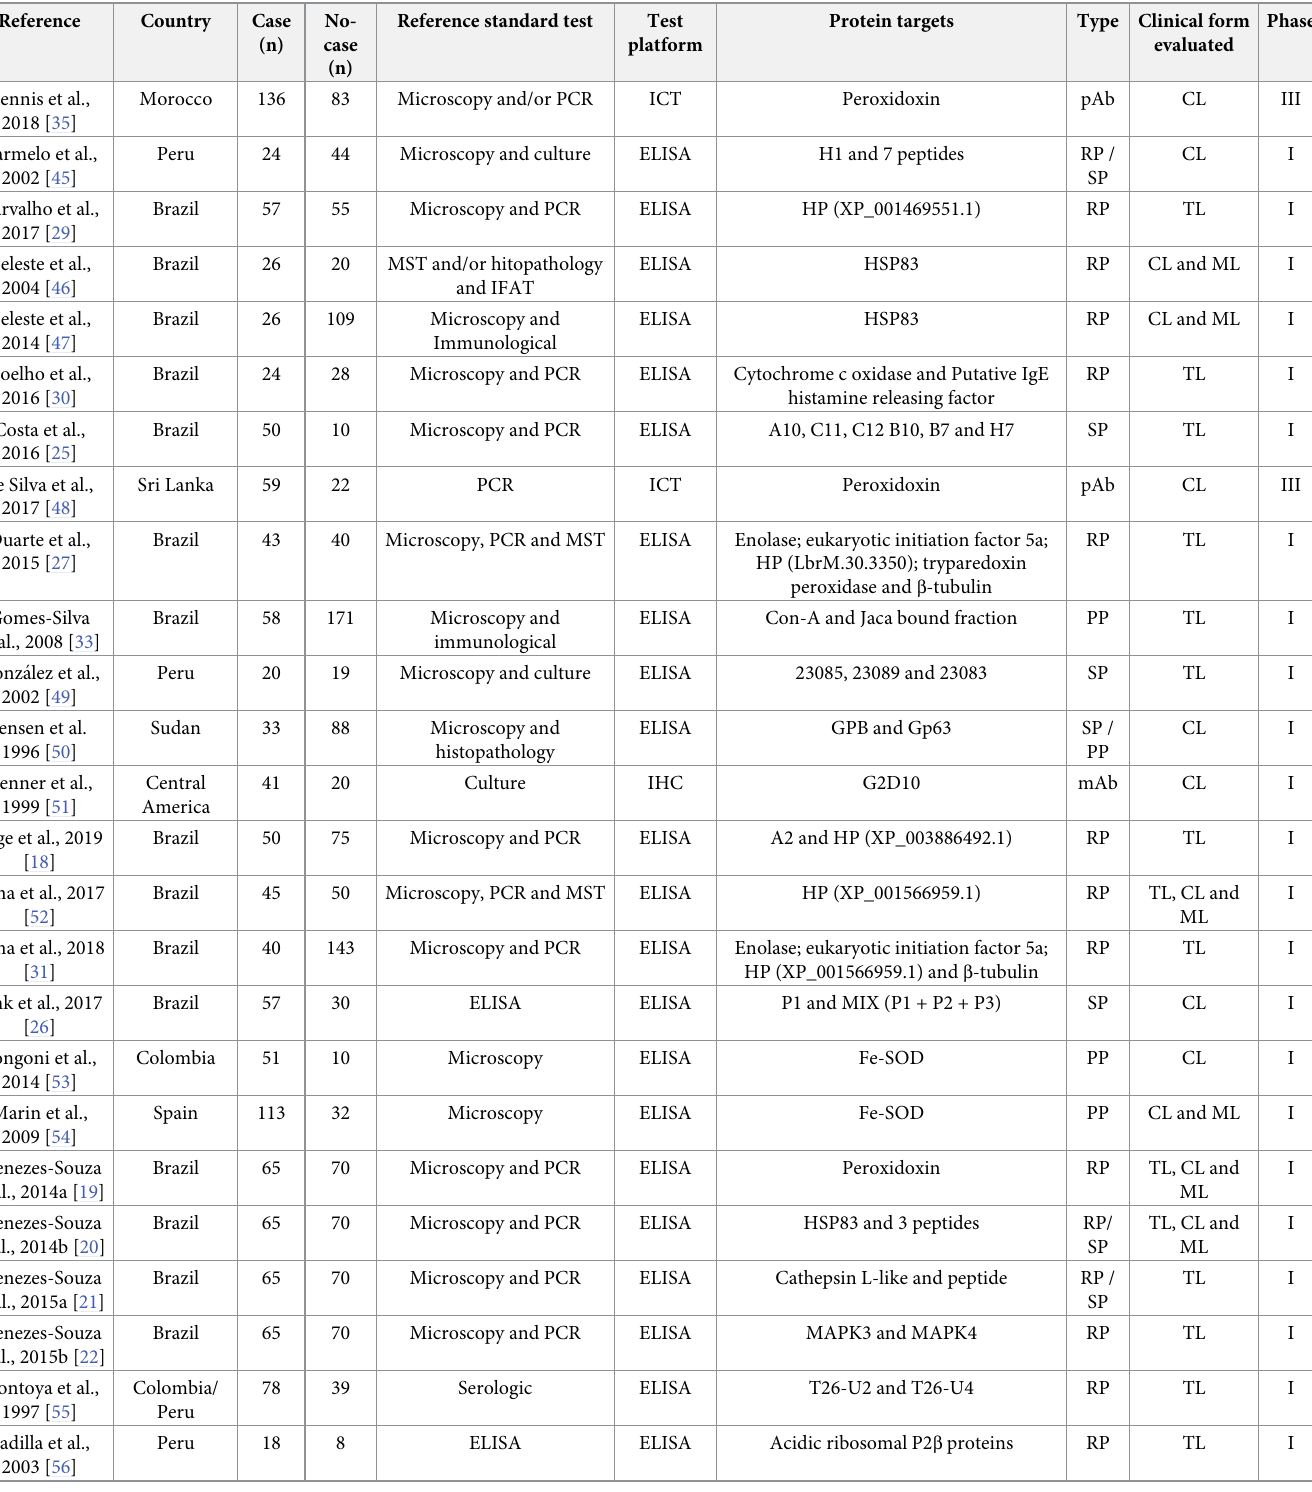
Table 1. Characteristics of the studies included in the systematic